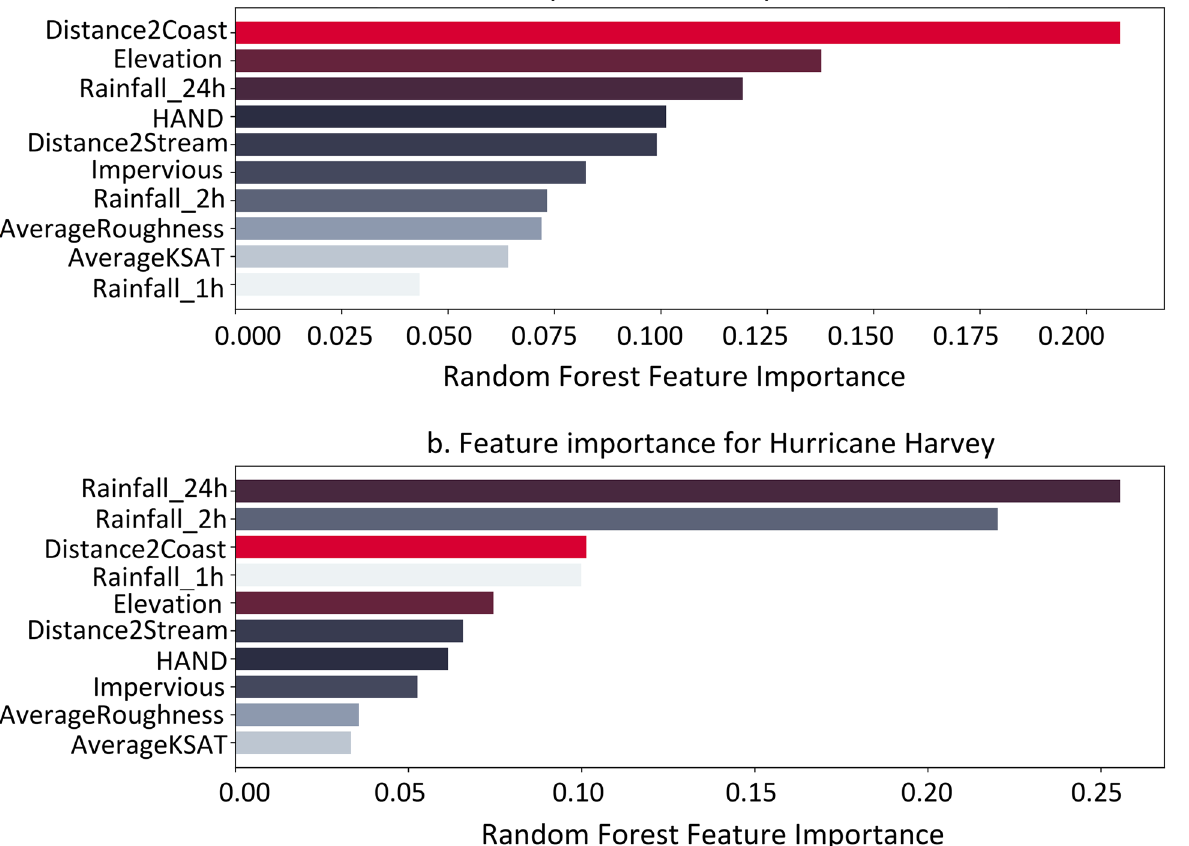
Fig. 6 Feature importance results for Tropical Storm Imelda ( a ) and Hurricane Harvey ( b ) with random forest. A larger value of feature importance indicates a more important role of that